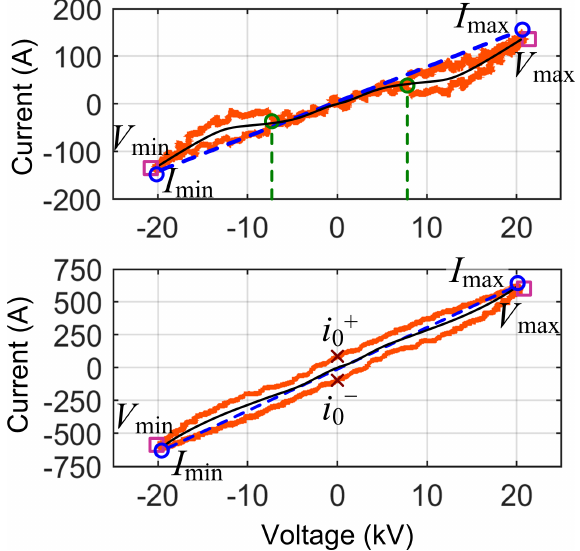
Figure 1. Example of the VI diagram and explanatory symbols for the locus features: blue circles for current extremes I max and I min , joined by the dashed extreme line; purple squares for voltage extremes V max and V min ; intersections with the vertical axis indicated by the brown crosses ( i + i − ); self intersections indicated by green circles; black curve for the mean 0